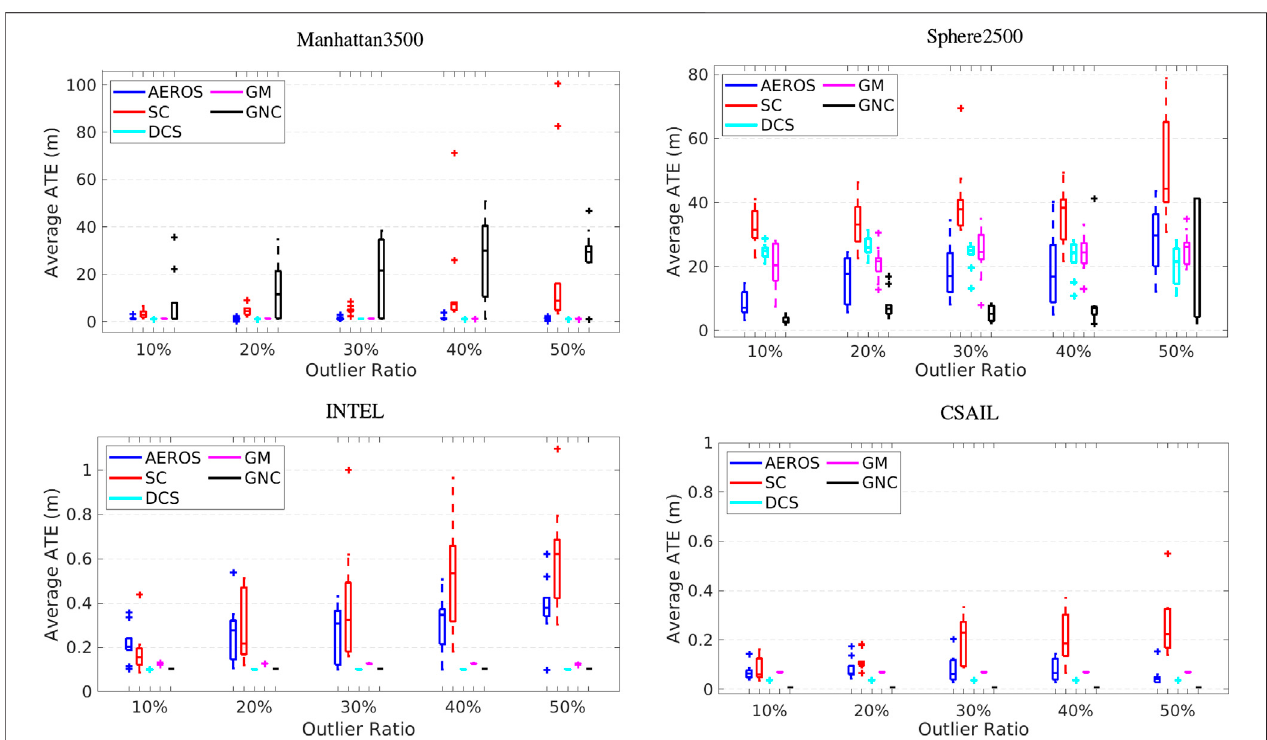
FIGURE 6 | Performance of AEROS compared with the state-of-the-art techniques for increasing outlier ratios. An average trajectory error for (top-left) 2D Manhattan3500 dataset, (top-right) 3D Sphere2500, (bottom-left) 2D INTEL and (bottom-right) 2D CSAIL dataset. Statistics are computed over 10 Monte Carlo runs.